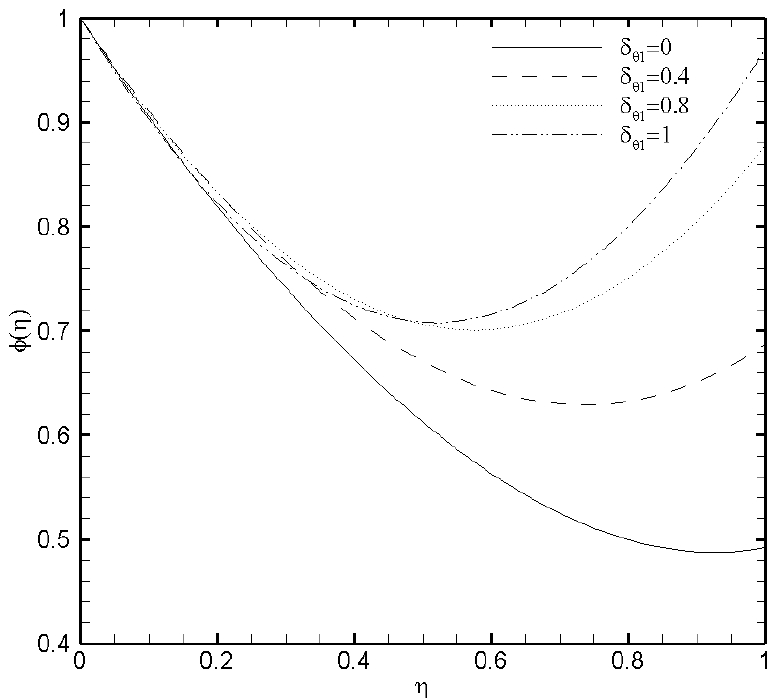
Figure 10. Nanoparticle volume fraction profile φ ( η ) for several values of a constant δ θ 1